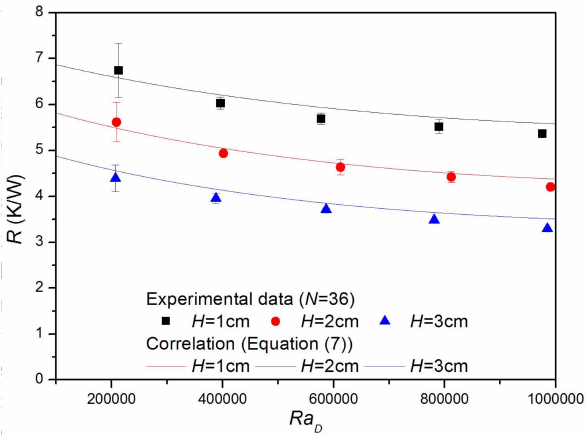
Figure 12. Thermal resistances for various fin lengths.